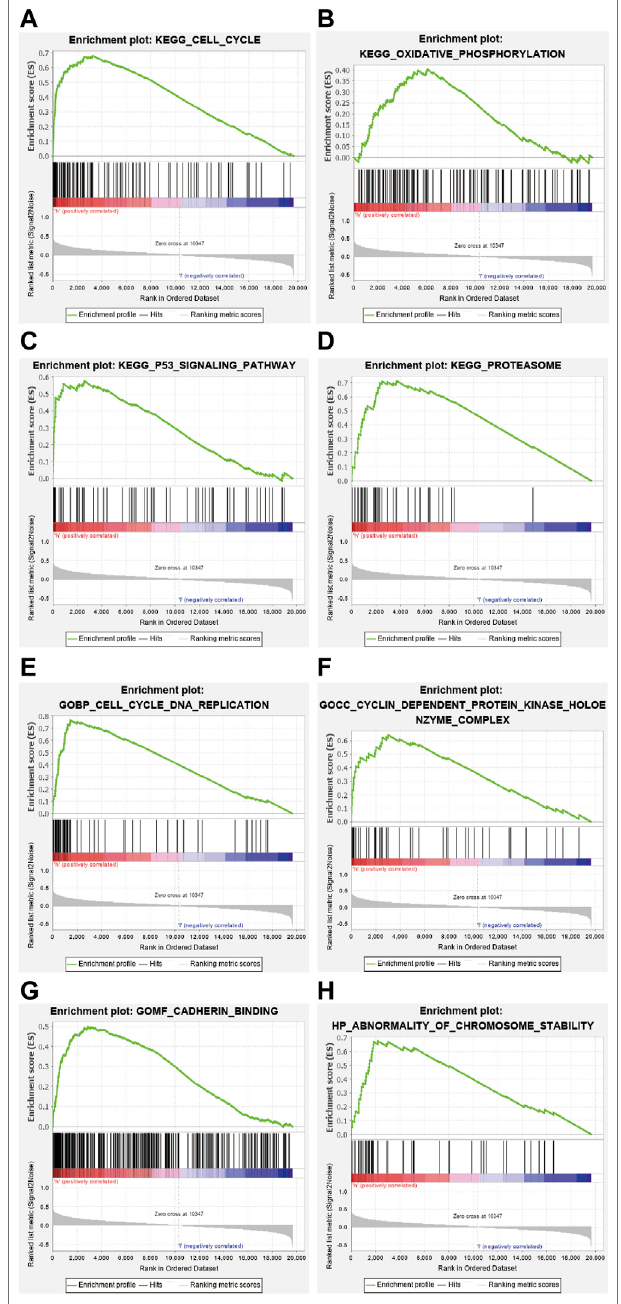
FIGURE 6 | Kyoto Encyclopedia of Genes and Genomics (KEGG) enrichment analysis revealed that genes identi fi ed were involved in the following processes ( A ) cell cycle, ( B ) oxidative phosphorylation, ( C ) P53 signaling pathway, and ( D ) proteasome. Gene Ontology (GO) enrichment analysis demonstratedthatthegenesetwasenrichedin( E )DNAreplication,( F )cellcycle regulation, ( G ) cell adhesion, and ( H ) chromosome variation.